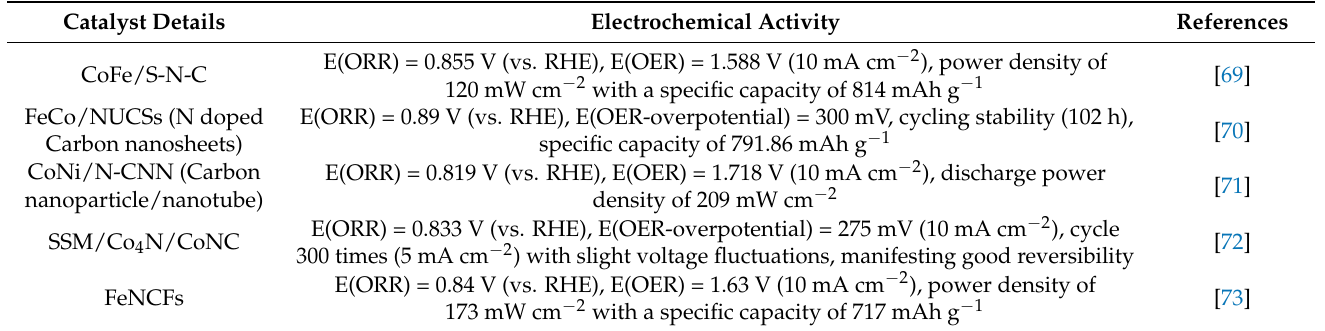
Table 1. Summary of electrocatalysts application in Zn–air